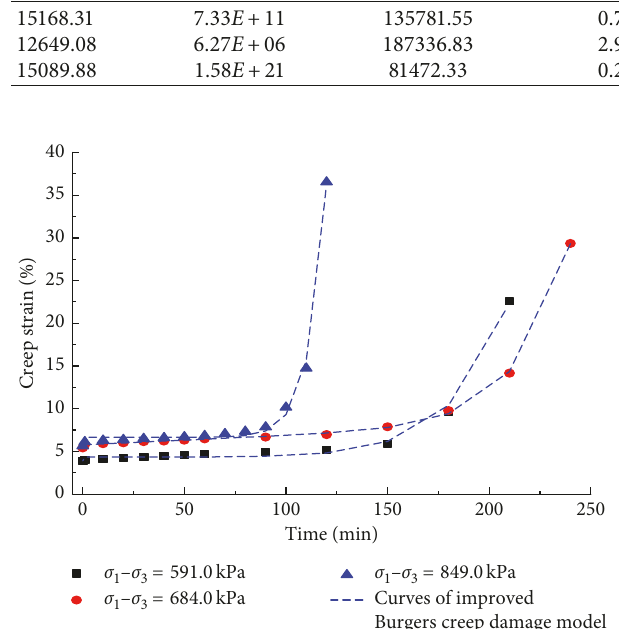
Table 7: Improved Burgers damage creep model parameters under different confining pressures. E 1 (kPa)